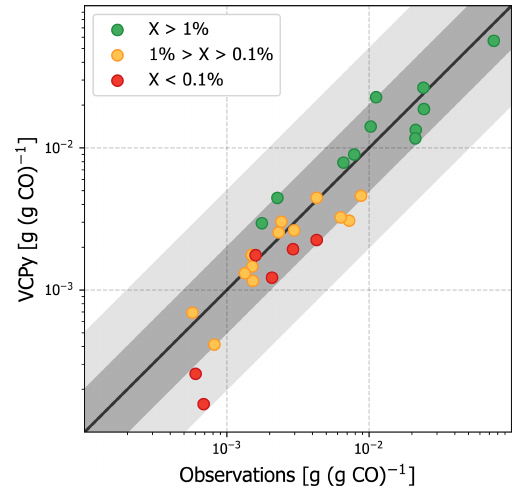
Figure 6. Evaluation of organic emission ratios in Los Angeles County using observed emission ratios from summer 2010. VCPy inventory ratios utilize VCPy predicted emissions for VCPs and the 2017 NEI for all other sources. The scatter point colors represent the relative abundance of each compound (represented as “X” in the figure legend) in the complete VCP sector. For example, all green points represent compounds that are > 1% of the total VCP emis- sions in Los Angeles County. The black line shows 1 : 1, the dark grey shading shows 2 : 1, and the light grey shading shows 5 : 1. Values available in Table